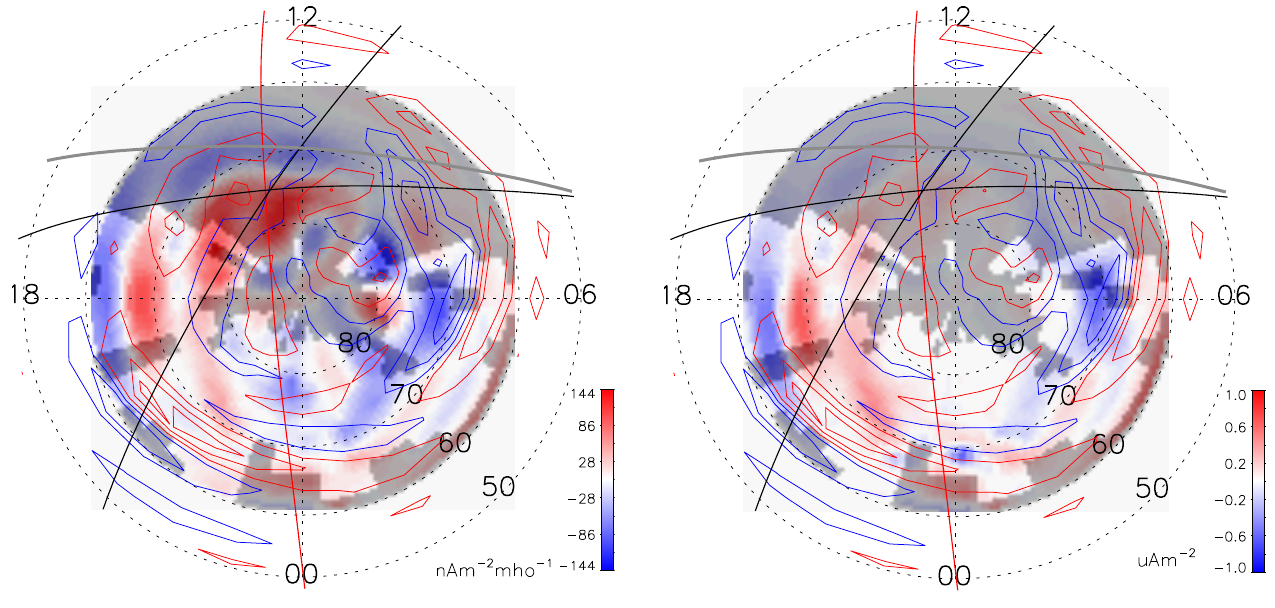
Fig. 9. J mod calculated from the inertial electric field for 1 Novem- k ber, 2001 as shown in Fig. 7 and a conductance model (see text). The currents obtained from the satellite data are shown as contours and the shaded regions indicate where there were no radar returns. term. The DMSP and Oersted satellite tracks and sunlight terminator are P also